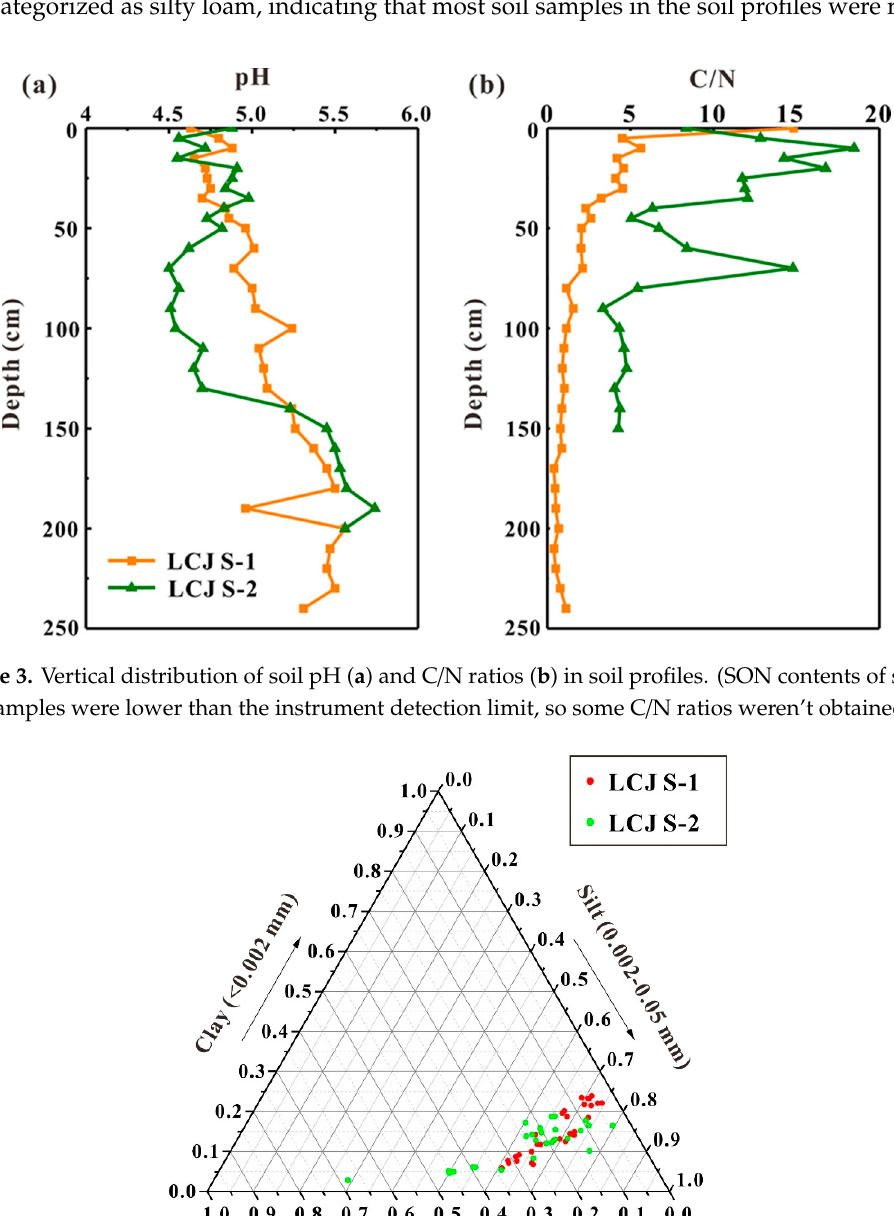
Figure 4. Ternary diagram of soil texture.